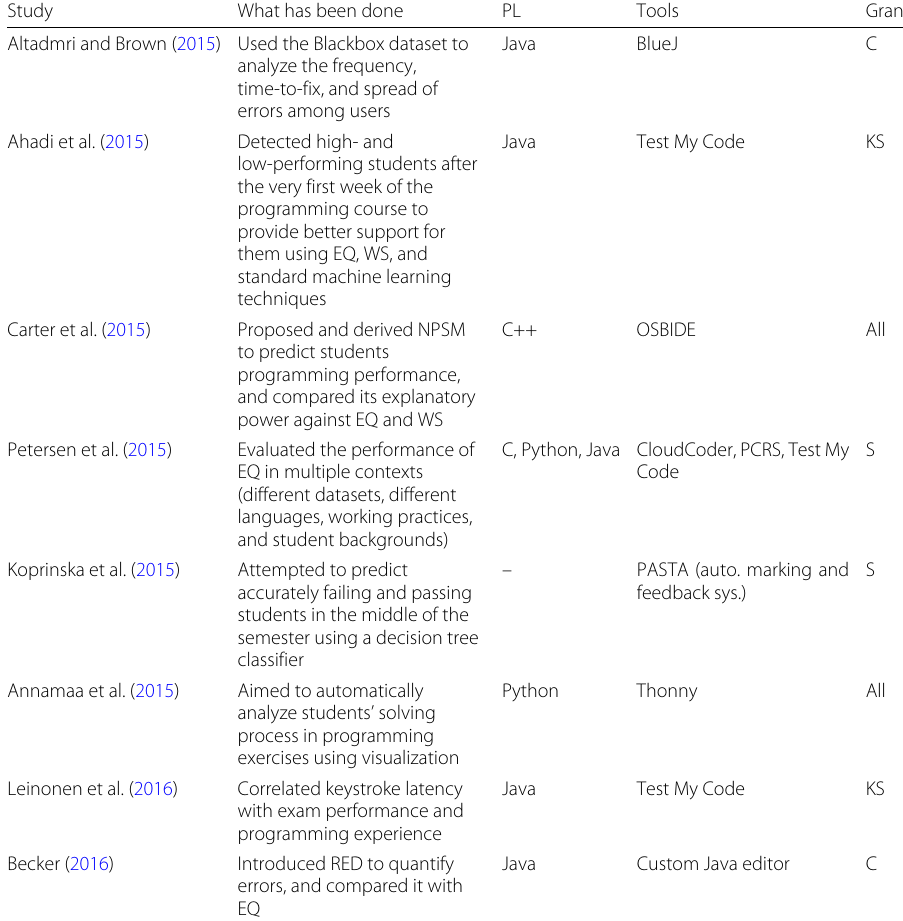
Table 1 Studies conducted using a process-oriented approach in the context of novice programming ( Continued ) Study What has been done PL Tools Gran. Altadmri and Brown (2015) Used the Blackbox dataset to analyze the frequency, Ahadi et al.